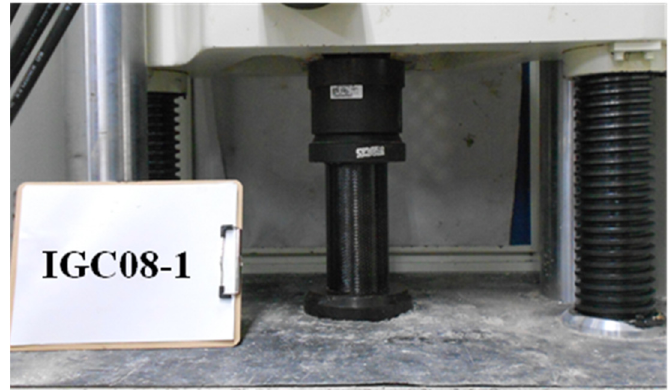
Figure 7. The illustration photo of compression test for cylindrical specimen.